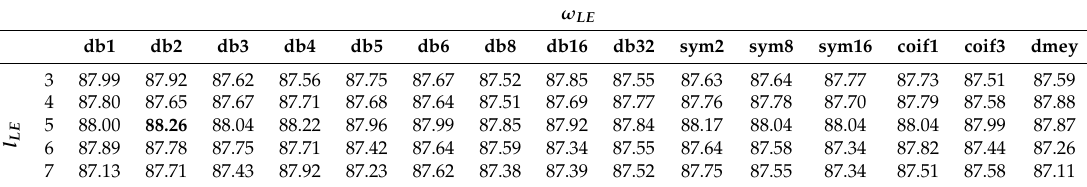
Table 22. The accuracy (%) of three class sleep stage classification with different ω LE and l LE under AASM standard.